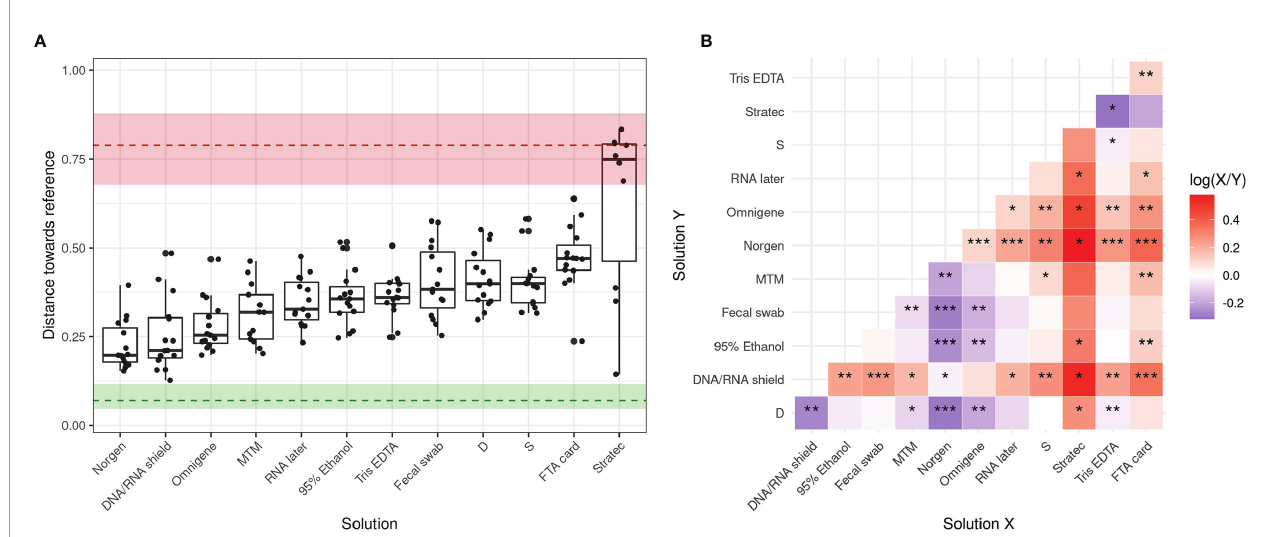
FIGURE 4 | Summary of community shifts in response to stabilizing solutions over a 14-day storage period. (A) Bray-Curtis distance towards the reference for each patient grouped by stabilizing solution. Median and 5th-to-95th percentile ranges are shown for both interaliquot and interpatient variability. (B) A pairwise paired Wilcoxon test was performed to compare solutions with each other, the color code refers to the log10 fold change of the median performance across patients: blue if the solution on X axis performs better, red if the solution on Y axis performs better. Signi fi cance is shown as follows: (*) indicates fdr<0.05, (**) indicates fdr<0.01, (***) indicates